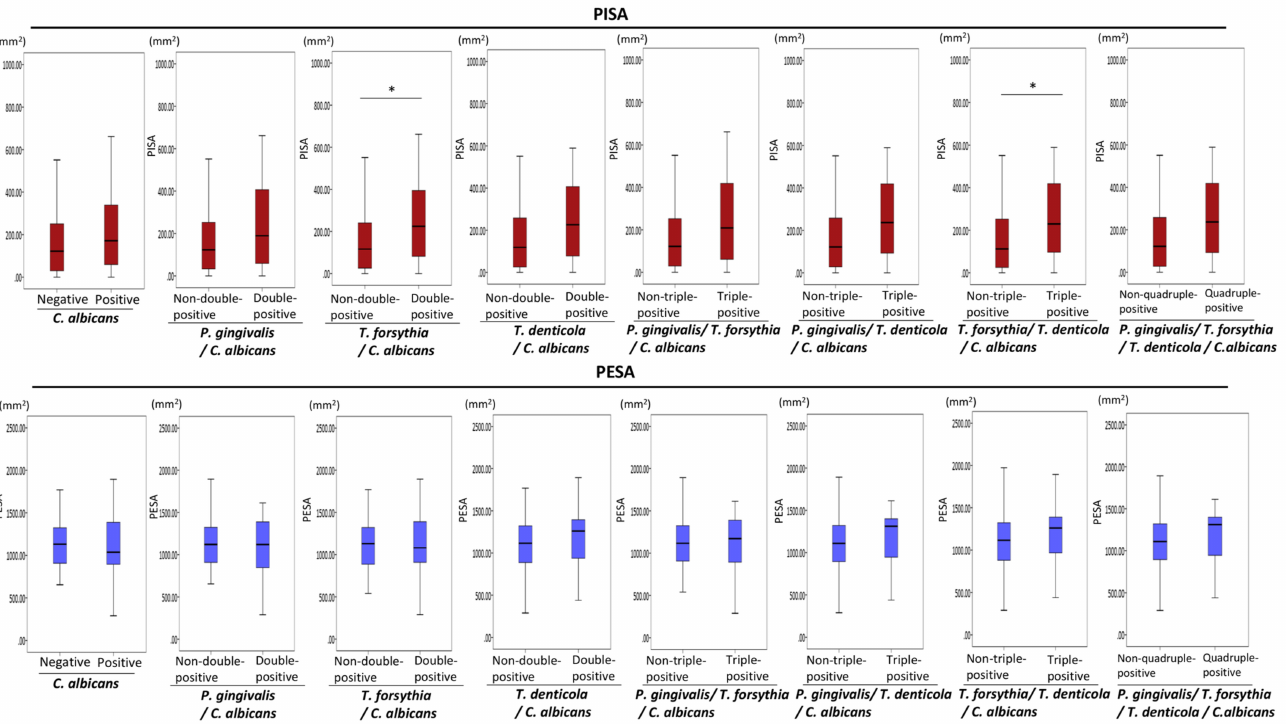
Figure 4. Associations of the combined presence of periodontopathic bacteria and candida with PISA and PESA. Mann– Whitney U test. Statistical significance levels of p < 0.05 are indicated by